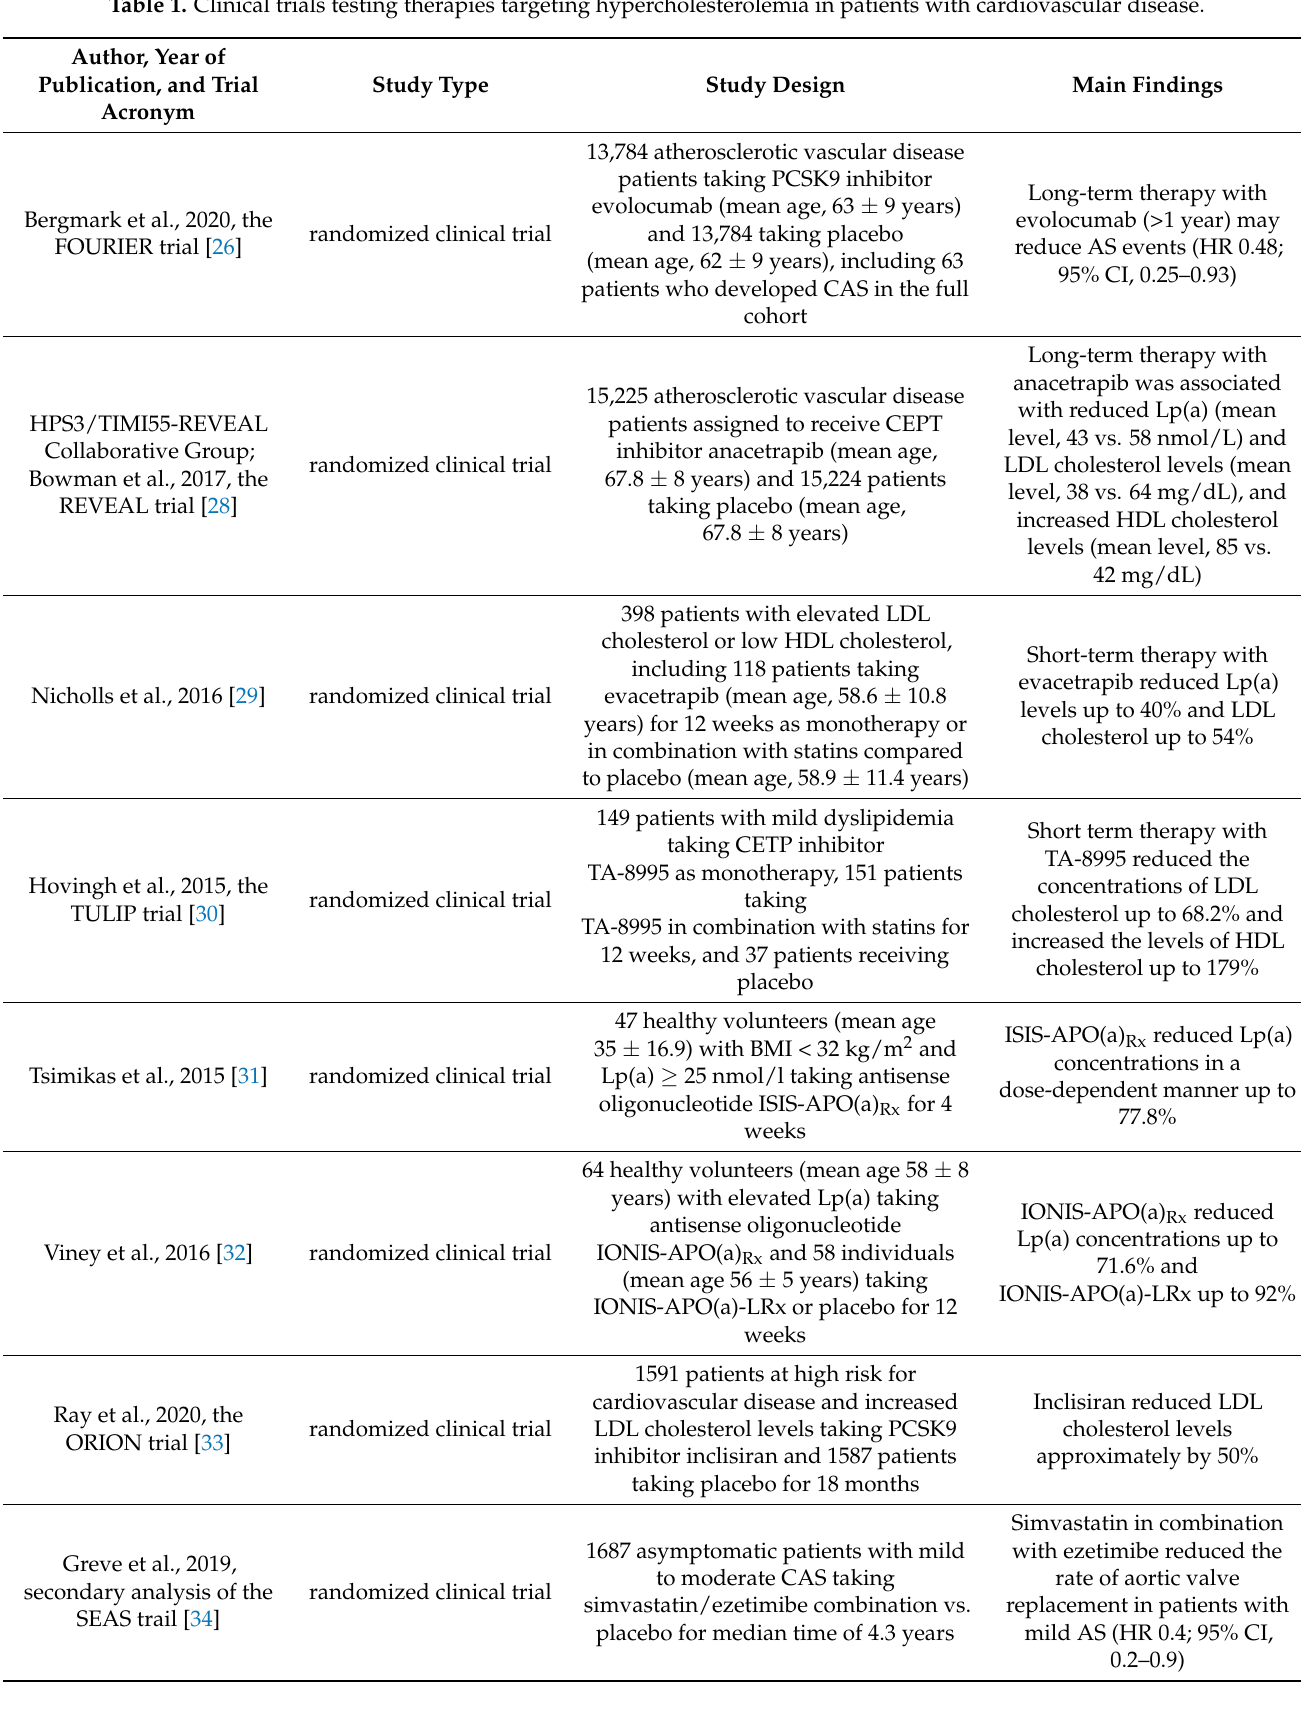
Table 1. Clinical trials testing therapies targeting hypercholesterolemia in patients with cardiovascular